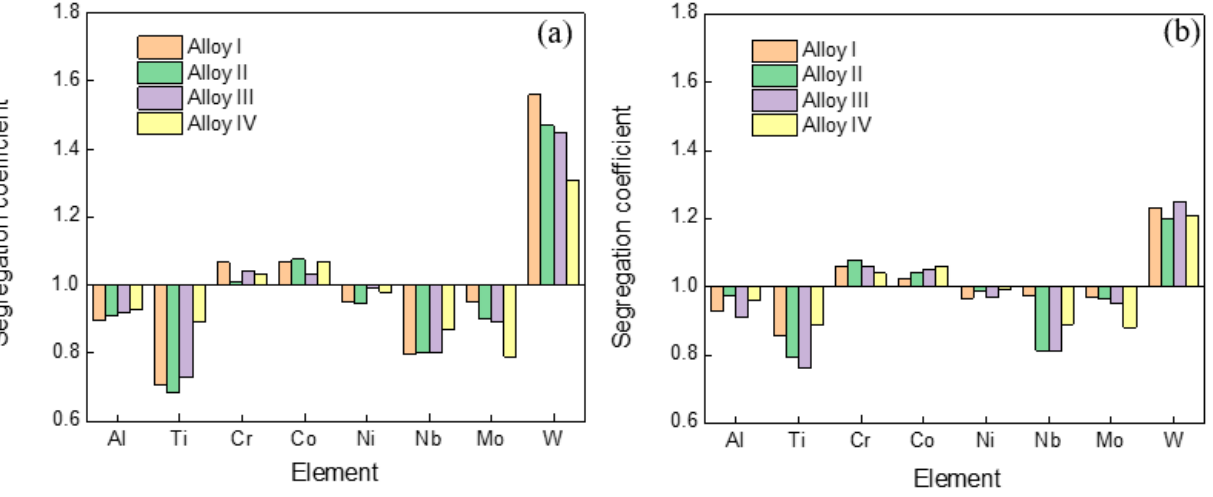
Figure 3. Segregation coefficient k of different elements in the alloys with different Mo contents: ( a ) cast state, ( b ) heat-treated state.